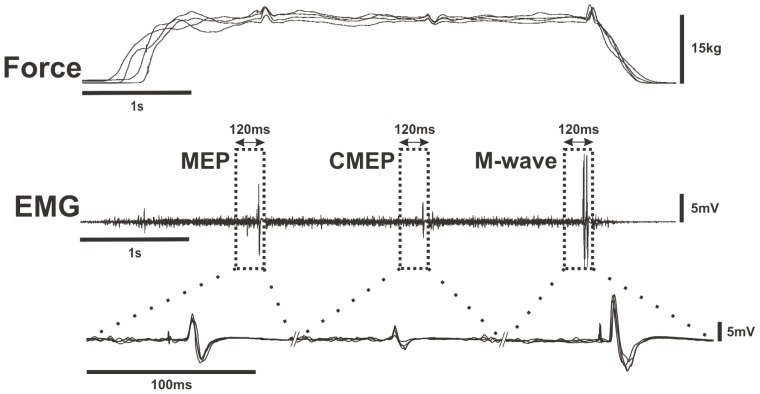
Consistency of the elbow flexion force tracing procedure and corticospinal responses in the biceps brachii within and between set contractions recorded from a chronic-RT subject.Individual raw data traces from a single subject for 4 contractions across four sets at 40% MVC (TOP). Individual raw data traces from the same subject showing EMG responses of the biceps brachii following each stimulus (transcranial magnetic - MEP, cervicomedullary - CMEP and brachial plexus - M-wave) for the 4 contractions (middle). Boxes were placed around the MEP, CMEP and M-wave and magnified for clearer illustration (bottom). MEPs, CMEPs and M-waves were very consistent within each contraction and between set contractions at the same relative intensity. Since TMS and TMES were triggered at 1 s and 2.5 s, respectively during all contraction intensities, MEPs and CMEPs overlap in the EMG Waveform. Erb's point stimulation was manually triggered at ∼4 s thus M-waves do not overlap. In the magnified M-wave waveform, M-waves from each contraction were matched by the onset of stimulus artifact.